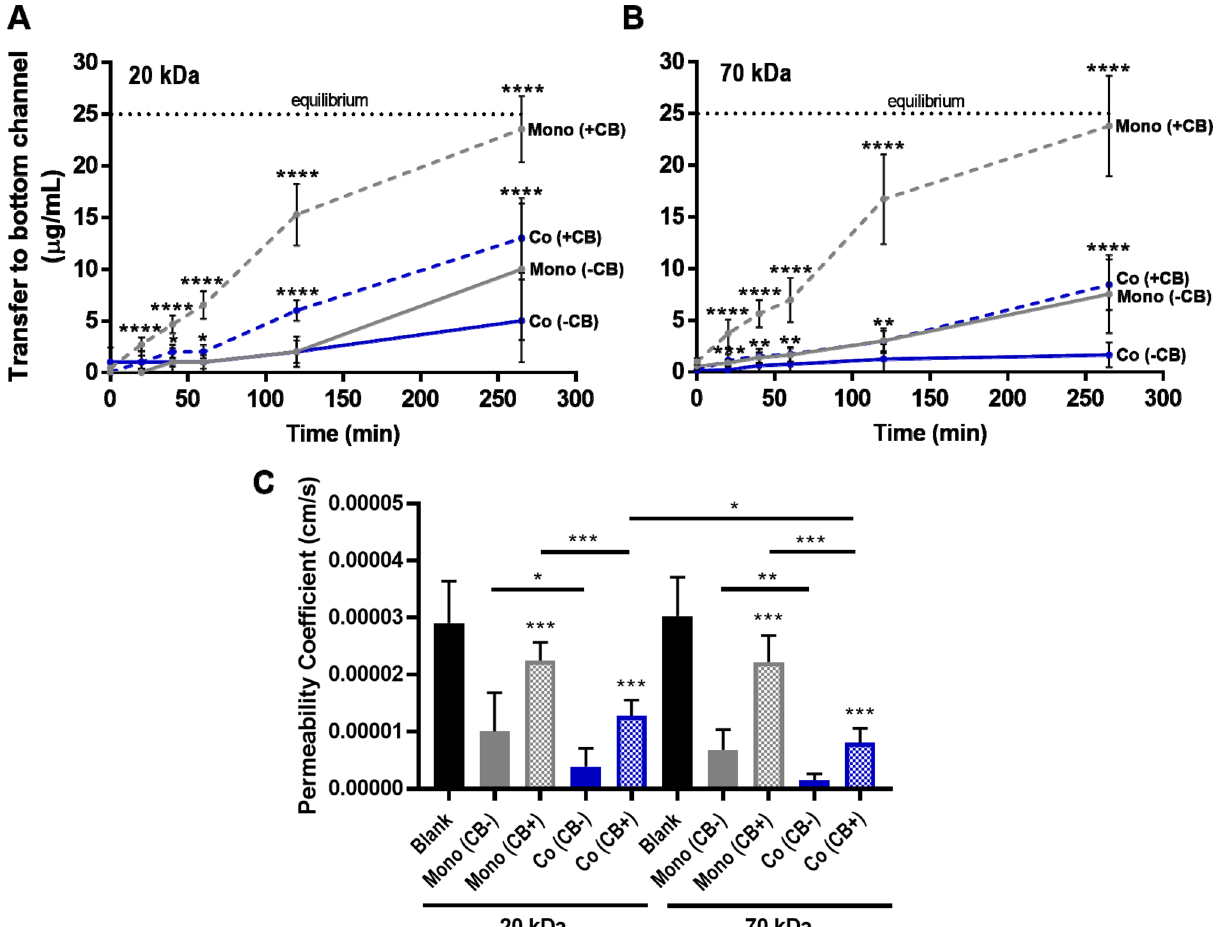
Figure 3. Permeability assays in PREDICT96 vascular models. FITC-dextran was loaded at a concentration of 50 μg/ml into the top channel of devices and transfer to the bottom channel was tracked over time. Note that equilibrium between both channels would be at 25 μg/mL (indicated by black dotted line). Both EC mono- culture (Mono) and co-culture with PC (Co) were assessed. Treatment with cytochalasin B (CB) was used to disrupt the barrier (added at t = 0). Transfer of ( A ) 20 kDa FITC-dextran and ( B ) 70 kDa FITC-dextran across the vascular barrier was measured at various intervals over 260 min. ( C ) Permeability coefficients were calculated at the 260 min time point for each condition assayed in the PREDICT96 plate. N = 8–10 technical replicates per condition. Asterisks in A and B indicate significant difference in + CB treated conditions compared to -CB controls at corresponding time